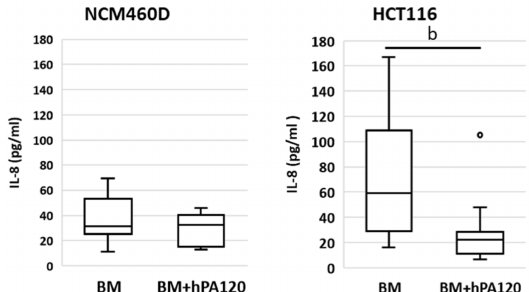
Figure 7. Secretion of interleukin 8 (IL-8) by cancer (HCT116) and healthy (NCM460D) human colono- cytes after 2-h incubation with fecal bacterial cultures grown in Wilkins–Chalgren medium supplemented with mucin (BM) and phytate. Colonocytes were incubated with BM alone or BM and phytic acid hydrolysate (BM + hPA120). Whiskers—non-outliers, box—25–75% non-outliers; horizontal line in the